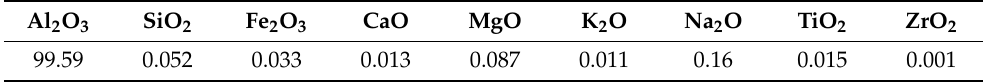
Table 1. Chemical composition of the alumina powder (wt%). Al 2 O